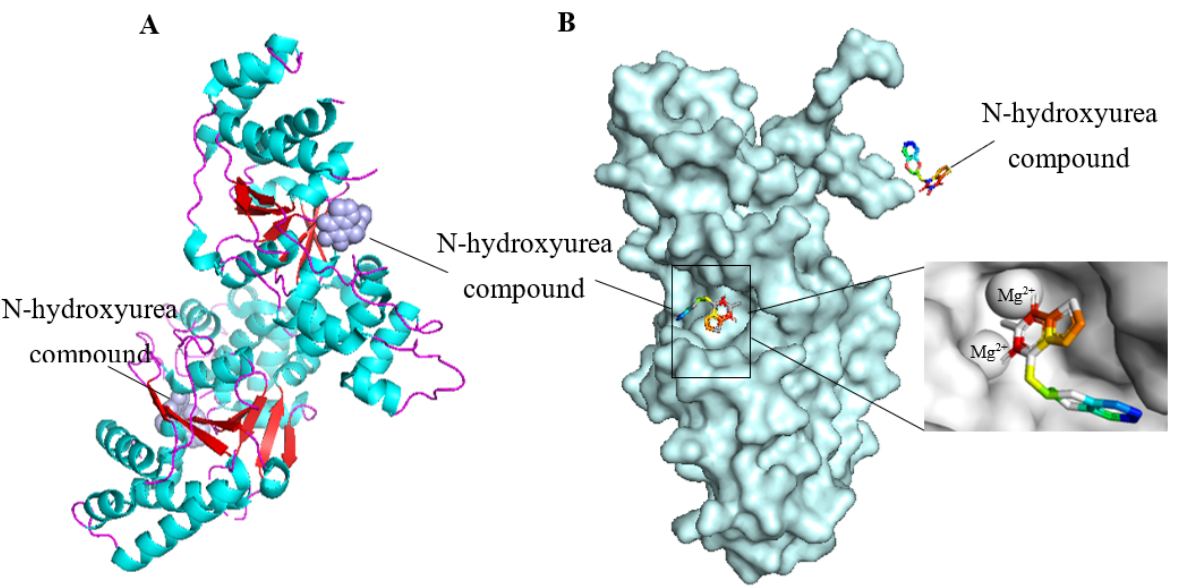
Figure 5. The molecular docking models of hFEN1 and small molecule compounds. ( A ) Superposition of N-hydroxyurea compound (purple) in the secondary structure hFEN1 (PDB ID: 5FV7). ( B ) The structure of N-hydroxyurea compound (colored) in the hFEN threading structure (white, PDB ID: 5FV7). The N-hydroxyurea compound and Mg 2+ are